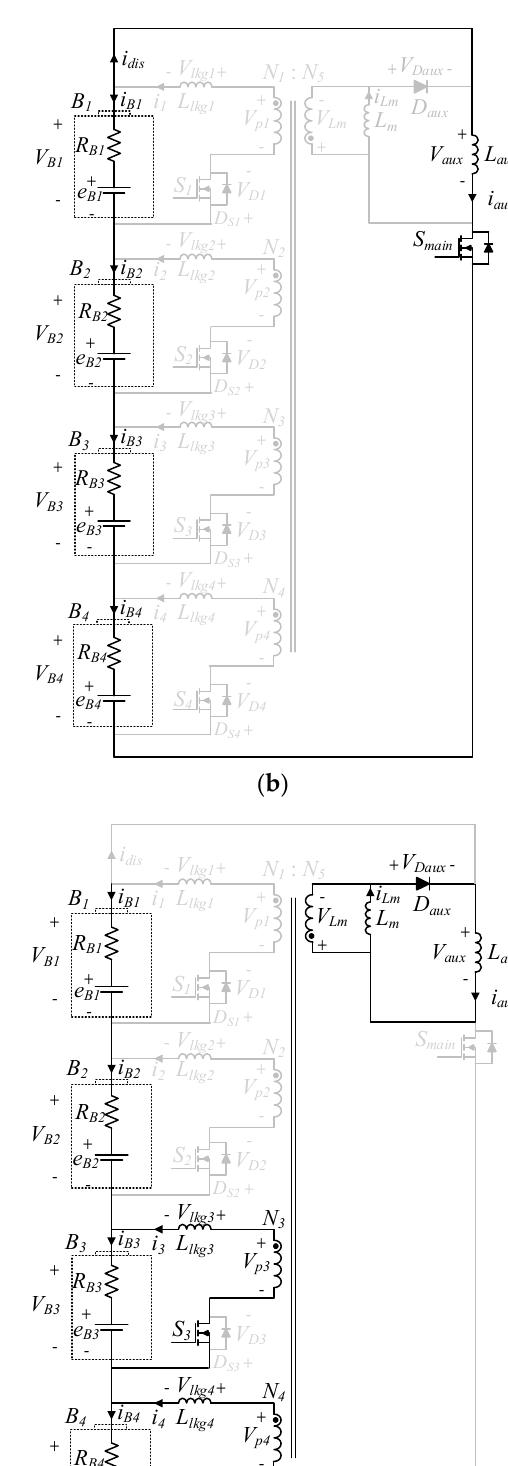
(9) (3) Mode 3 ( t 2 ~ t 3 ): Mode 3 starts at t 2 , at which point S main is turned off, and the lower- voltage battery side switches S 3 and S 4 (connected to B 3 and B 4 ) are simultaneously turned on. At t 3 , the charging current of the battery cells is zero. As shown in Figure 8a, i aux starts to decrease linearly at t 2 . The equivalent circuit in Mode 3 is expressed as Figure 9a (since the transformer has the same winding ratio). As shown in the figure, i aux is divided into a magnetizing inductor and battery cells B 1 ~ B 4 through a multi-winding transformer; thus, i aux in Mode 3 is expressed as (10). In this case, i 1 ~ i 4 are expressed as (11) to (15). Since i 1 and i 2 flow through the anti-parallel diodes of the switch, the current value decreases, and i 3 and i 4 flow through the switch; this causes the current value to increase. In addition, V lkg 1 ~ V lkg 4 can be ignored because the leakage inductance of the transformer is assumed to be very small. In the case of Mode 3, the V aux , which denotes the voltage across the auxiliary inductor, is V t 3 , which is expressed as (15).